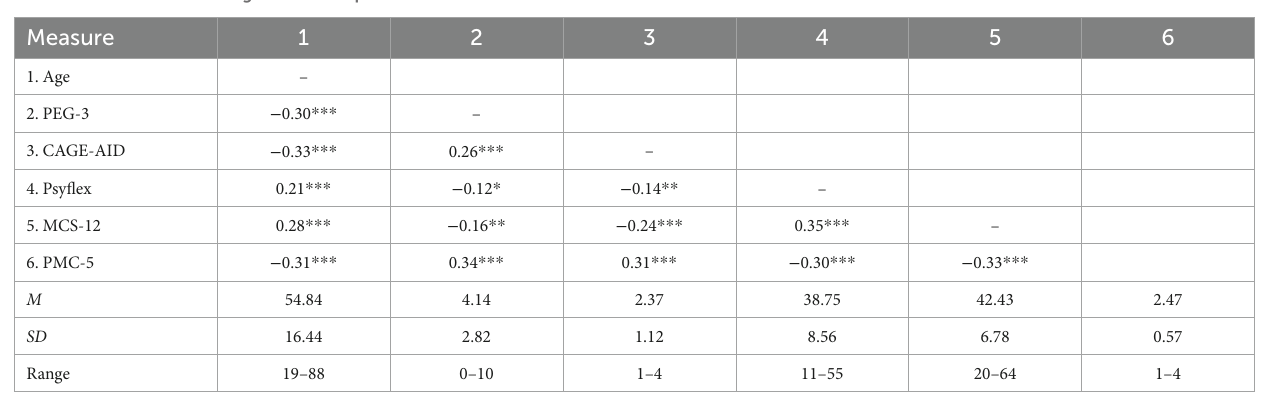
TABLE 2 Correlations among continuous predictor